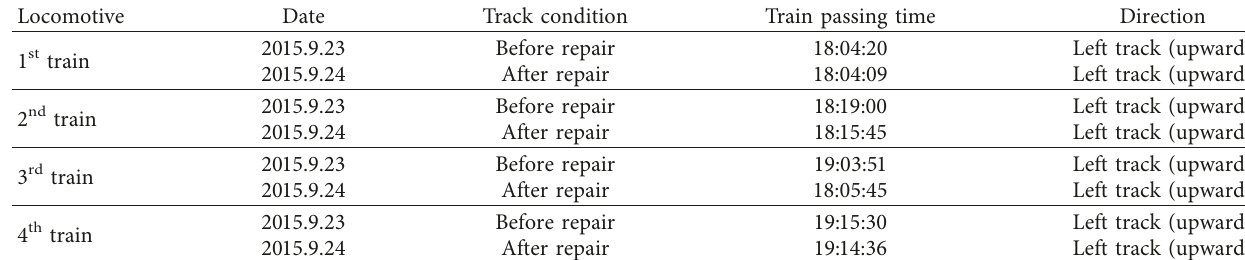
Table 6: Left track line on-site measurement